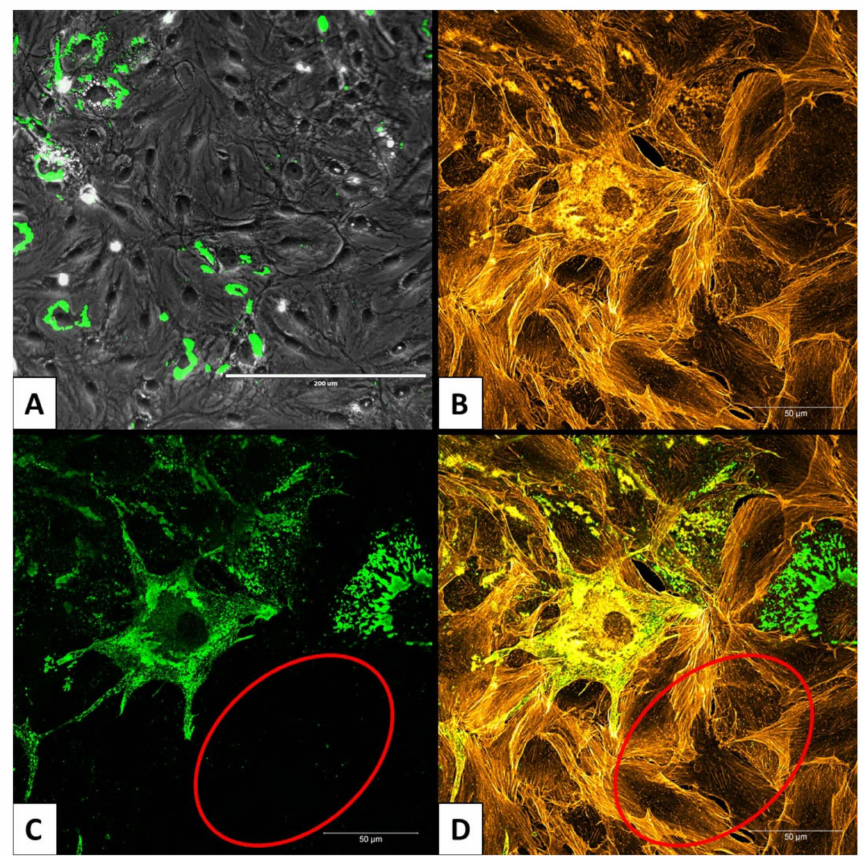
Figure 4. Persistently infected MoLu Prim_EBOV cells. Overview of persistently infected MoLu Prim_EBOV cells 143 dpi; scale bar: 200 µ m ( A ). Enlargement of MoLu Prim_EBOV cells; scale bar: 50 µ m. Stained actin filaments ( B ); stained EBOV-NP ( C ). Overlay B and C ( D ). Area with uninfected cells (red ellipse), EBOV-NP (green), actin filaments